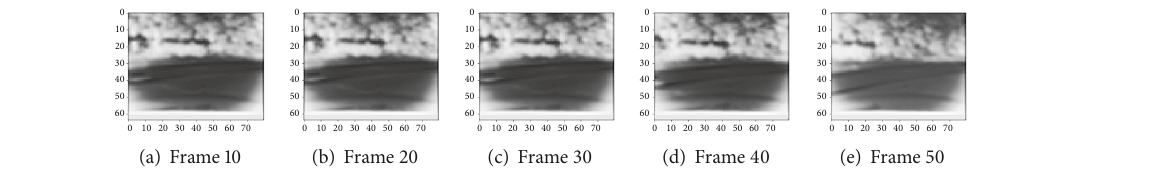
Figure 15: Predicted images after training (Crazy